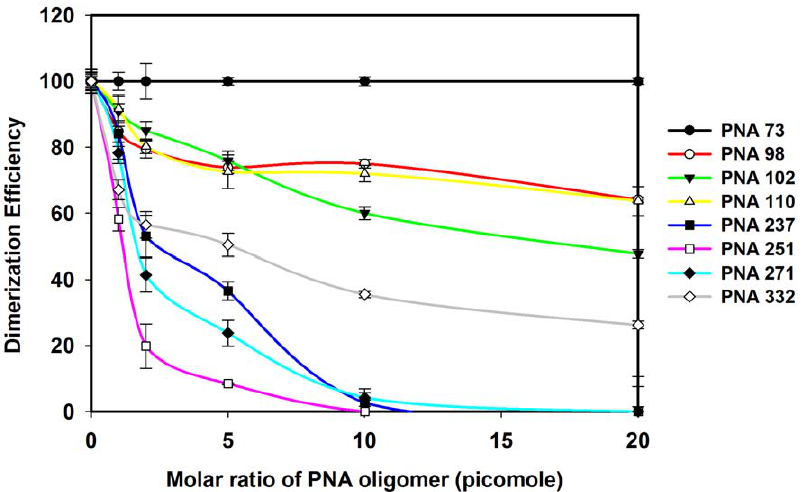
Figure 6. Effects of PNA oligomers on the efficiency of dimerization of HIV-1 RNA transcripts. The samples from dimerization assays were analyzed on the 4% non-denaturing gels and the intensity of monomer and dimer bands on each gel was quantified. The dimerization efficiency was calculated as d/D 6 100%, where d is the percentage intensity of dimer with different concentration of PNA and D is the percentage intensity of dimer in the absence of PNAs. Error bars indicate standard deviation from triplicate runs.